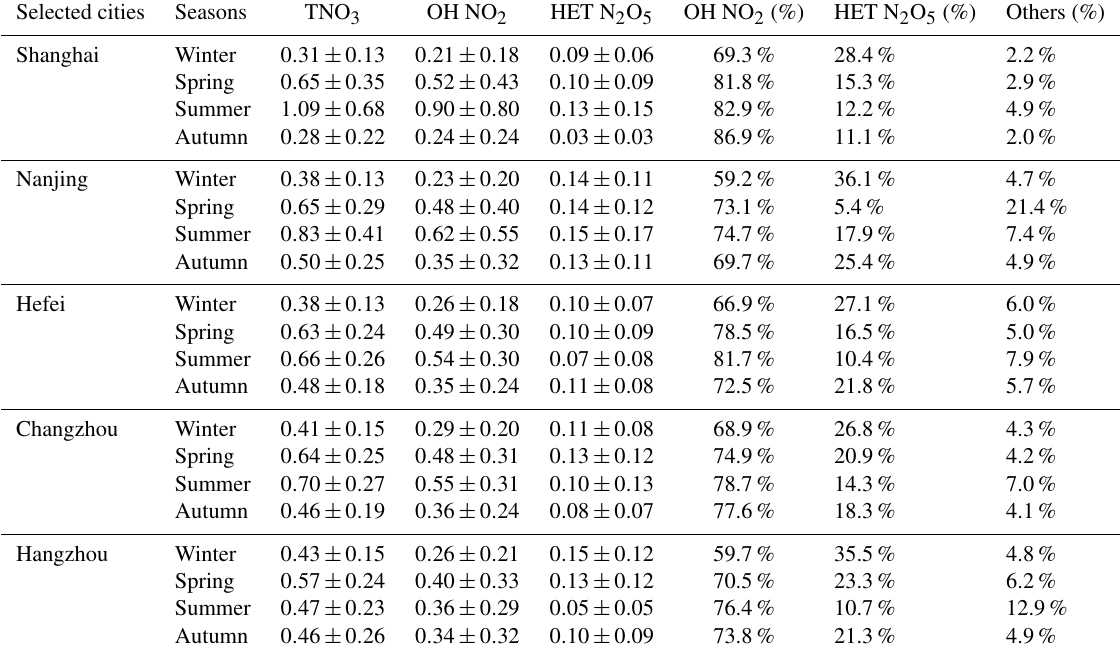
Table 3. Seasonal TNO 3 production rates (ppbh − 1 ) and contributions (%) of the major production pathways in five representative cities. Selected cities